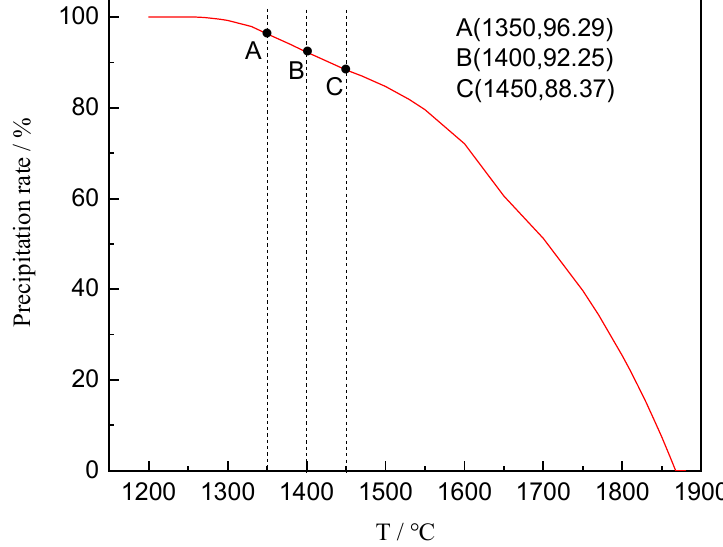
Figure 7. Theoretical transition fraction of a spinel crystal.